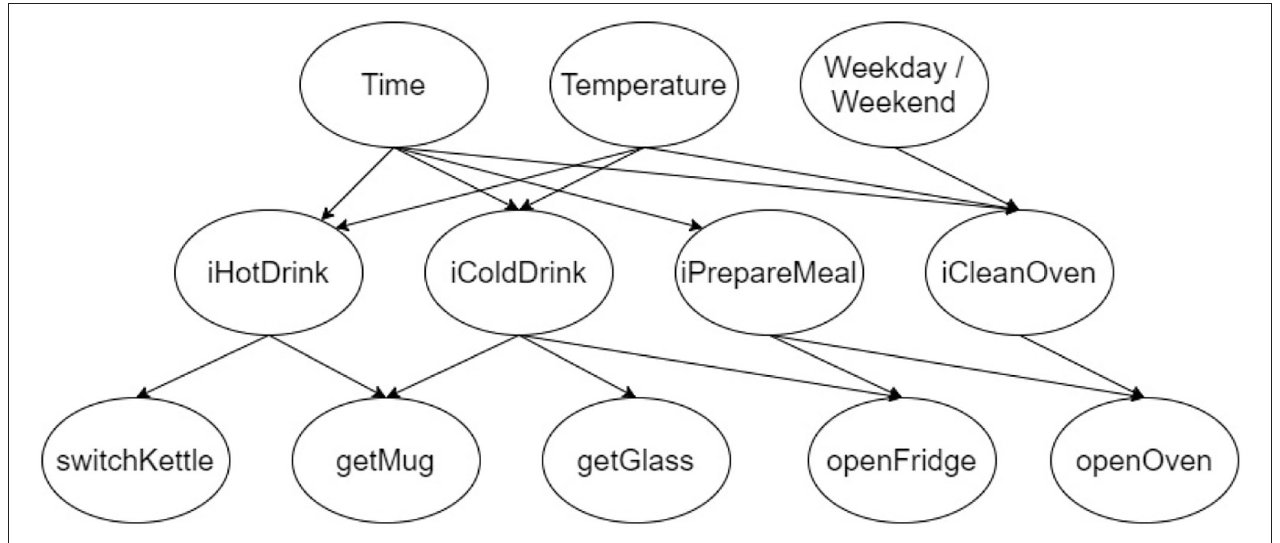
FIGURE 2 | Kitchen example graph